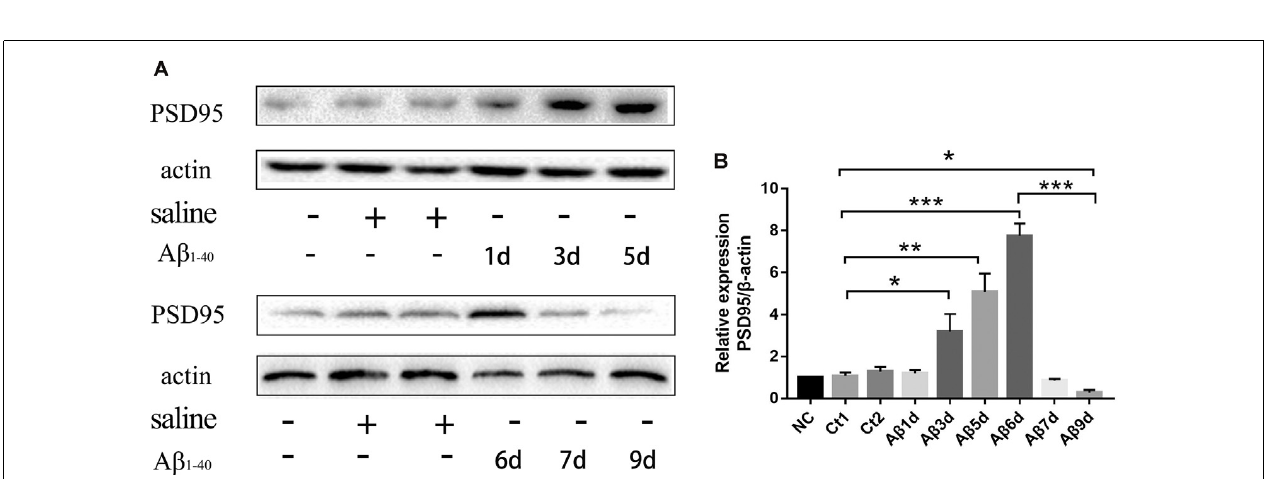
FIGURE 4 | The expression of PSD-95 protein at different times after continuous injection of HF-488-A β 1–40 . (A) A representative band of the expression of PSD-95 in hippocampus from Wt mice, control mice with the vehicle and A β -treated mice for 1, 3, 5, 6, 7 and 9 days. (B) Quantification of PSD-95 is normalized to β -actin and is shown as a % of control. Compared with the control group, the expression of PSD-95 was temporarily increased for 6 days, but the expression was decreased significantly for 9 days. n = 5. * p < 0.05, ** p < 0.01, *** p < 0.001.